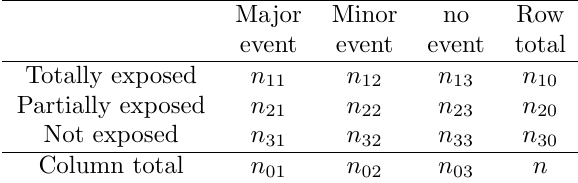
Contingency table with partial exposure and affection Major Minor no Row event event